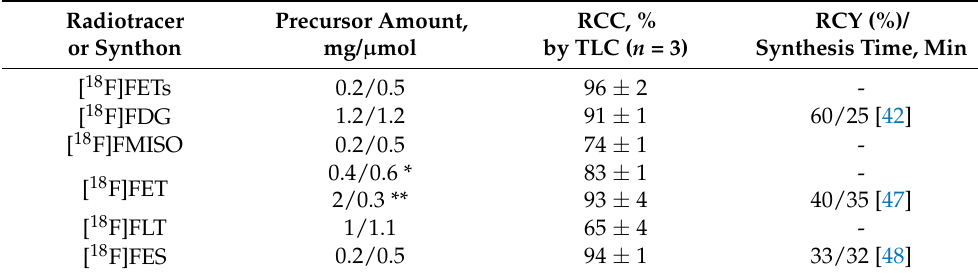
Table 1. The synthesis of radiotracers [42] via radiofluorination in the presence of Bu 4 NOTs (1 mg, 2.5 µ mol in 2 mL of EtOH, QMA carb, 46 mg); MeCN, 100 ◦ C, 10 min; RCY—radiochemical yields, non-decay